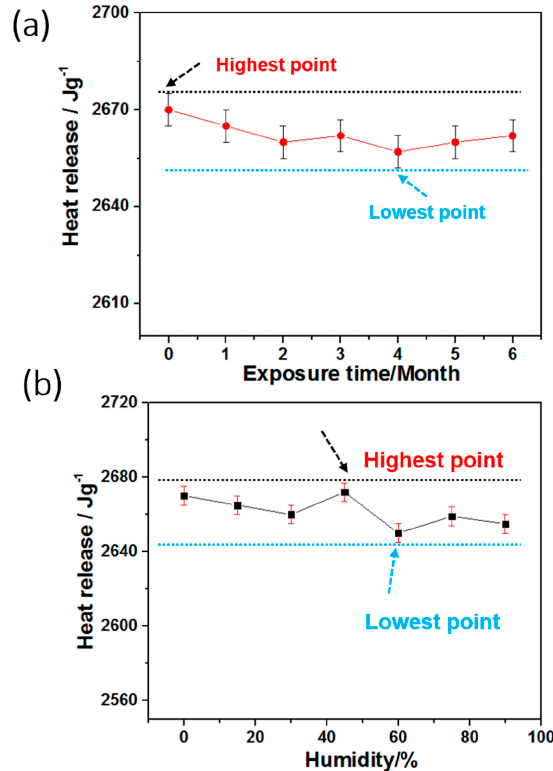
Figure 7. The relationship of the heat-release of products to ( a ) exposure time and ( b ) humidity.